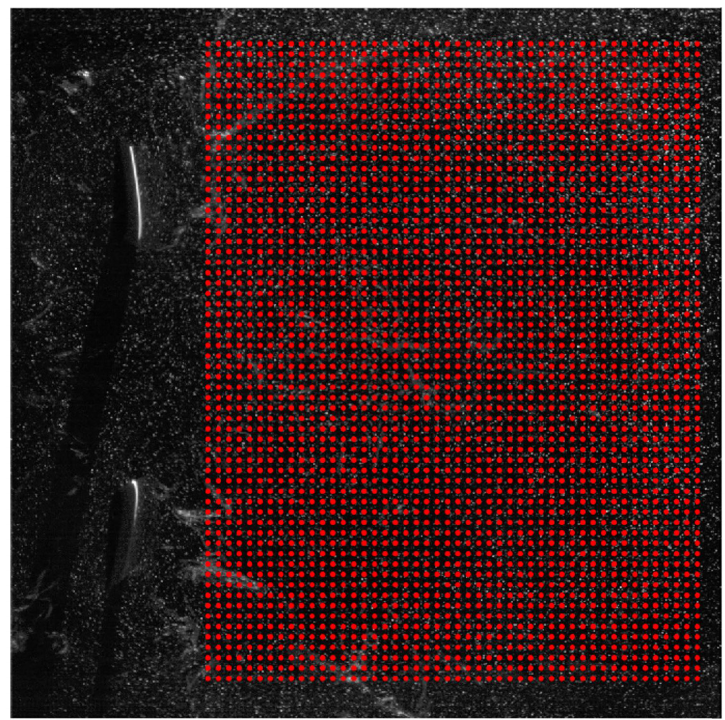
Figure 3. An example of the PIV calculation points on a raw